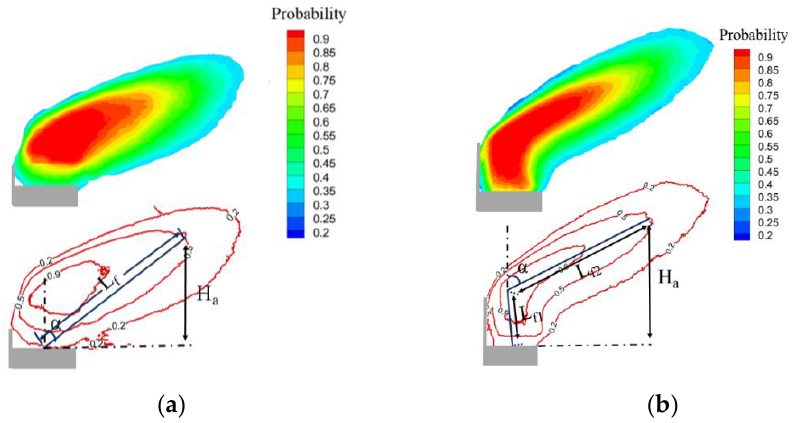
Figure 7. Definition of flame length and tilt angle in the presence of a baffle and crosswind: ( a ) H = 2 cm and ( b ) H = 4, 6, 8, and 10 cm.